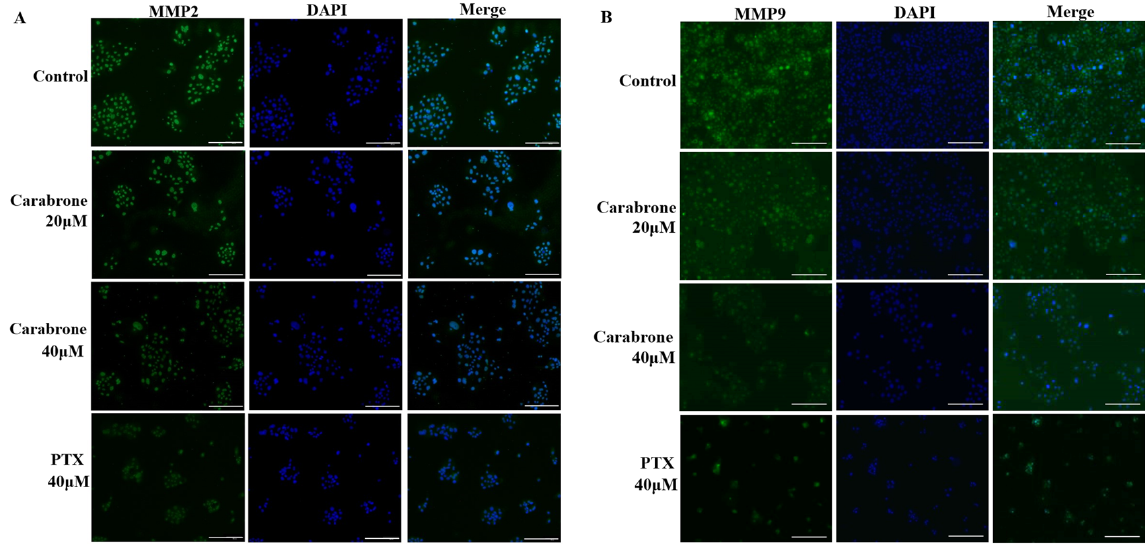
Figure 2. Effects of carabrone on MMP2 and MMP9 proteins in SW1990 cells. ( A , B ) Representative fluorescent images of SW1990 cells treated with carabrone and PTX for 48 h. (Scale bars: 100 μ m).